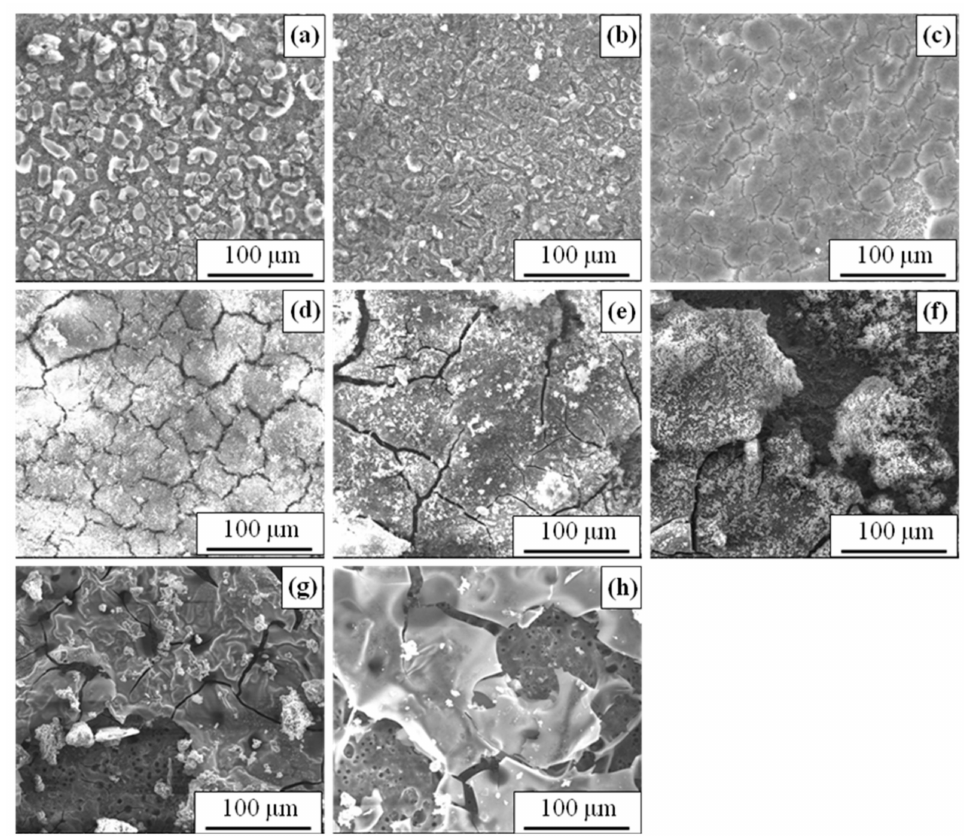
Figure 4. The surface morphology after 5 g/L ( a ), 10 g/L ( b ), 20 g/L ( c ), 50 g/L ( d ), 75 g/L ( e ), 100 g/L ( f ), 150 g/L ( g ), 200 g/L ( h ) phosphoric acid in conjunction with the tannic converter